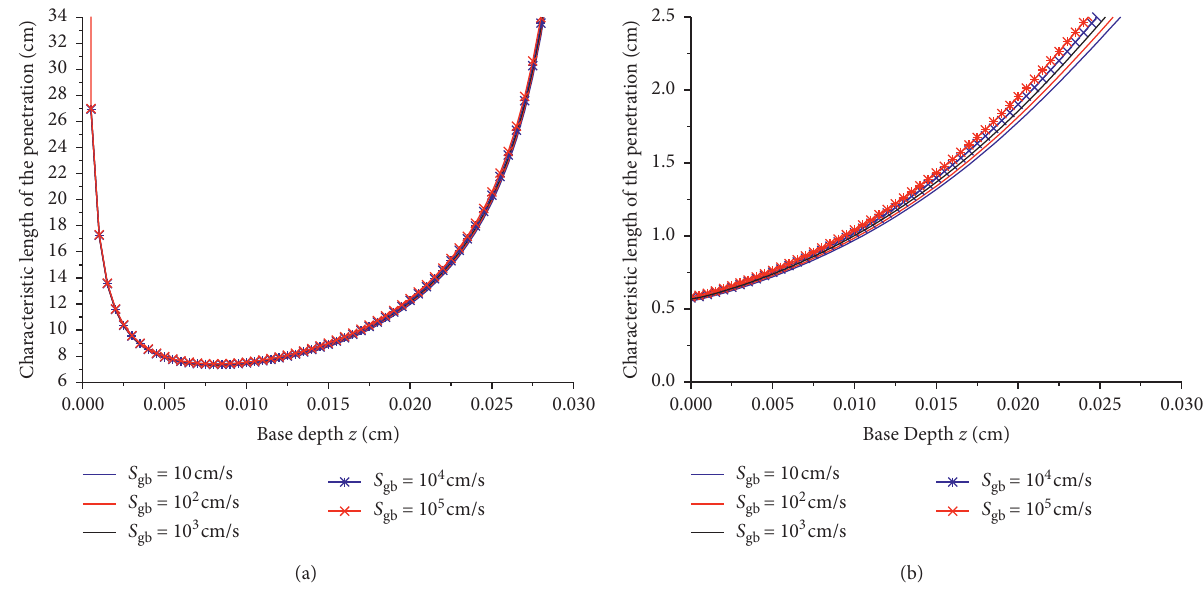
Figure 3: Characteristic length of the penetration versus base depth for different grain boundary recombination velocity in the short circuit (a) and open circuit (b) ( g � g x � g y �